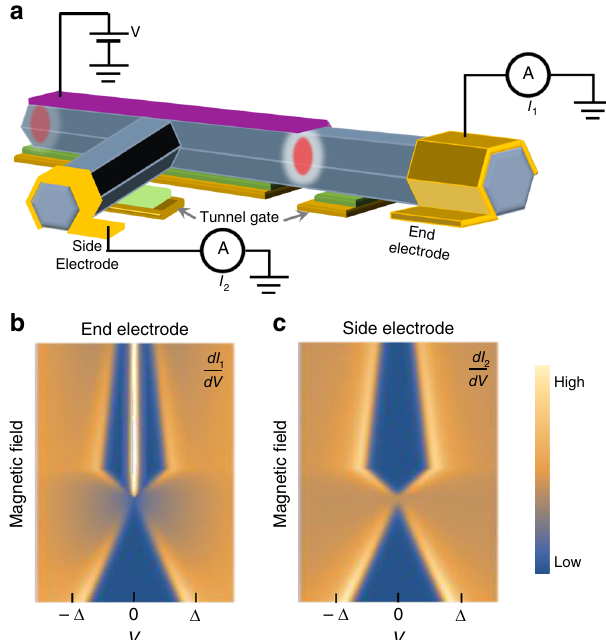
Fig. 4 Spatially resolving local density of states in a Majorana nanowire. a Schematic experimental setup for a three-terminal T-shape device to resolve the LDOS at the end and middle of a Majorana nanowire. b Schematic plot of d I 1 /d V from the end electrode probing the LODS at the wire end. c Schematic plot of d I 2 /d V from the side electrode probing the LDOS in the wire middle, which shows no zero bias